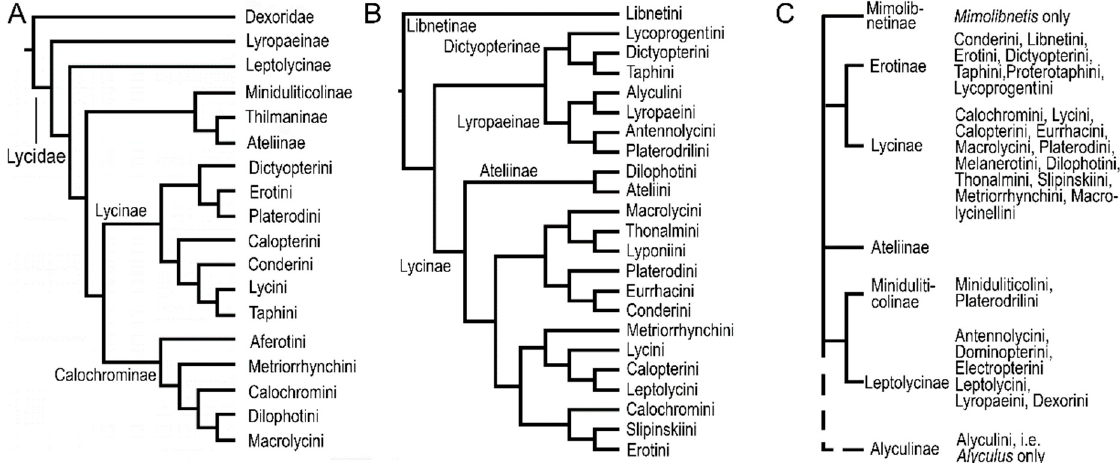
Figure 1. Overview of net-winged beetle classification. ( A ) Kazantsev (2005) [17]; ( B ) Bocak et al. (2008) [23]; ( C ) Kazantsev (2013) [35].